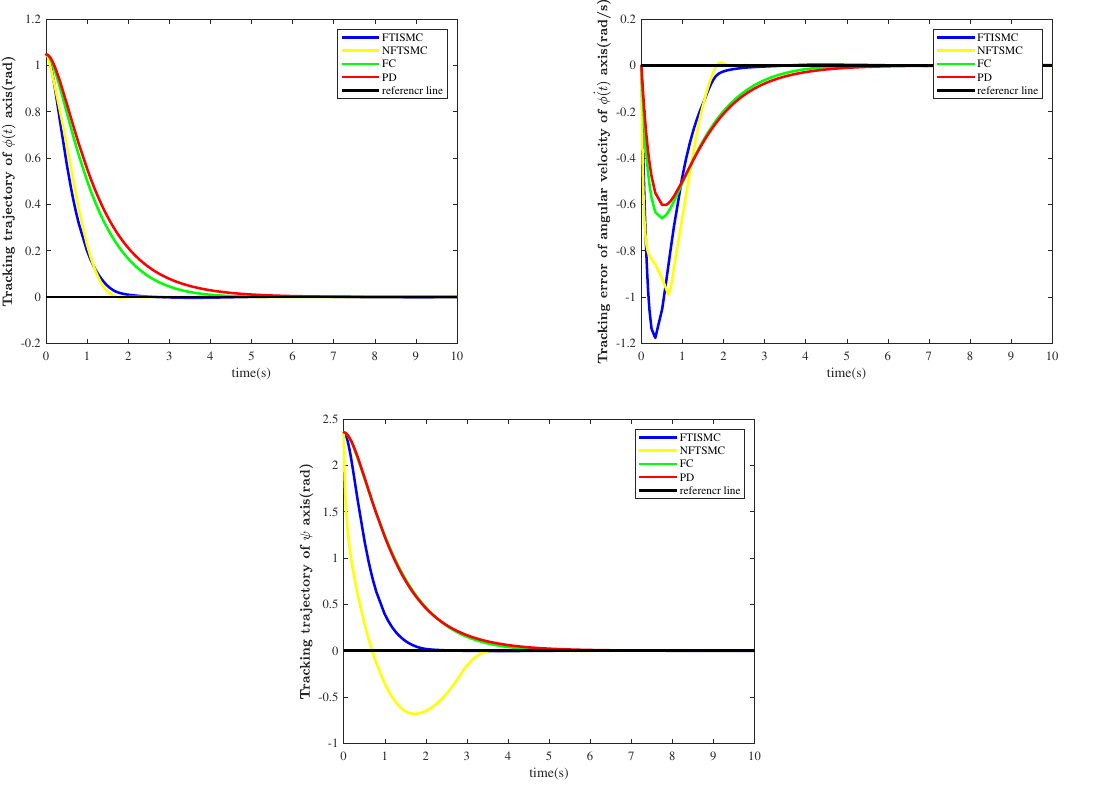
Figure 3. Attitude angle tracking trajectories of different